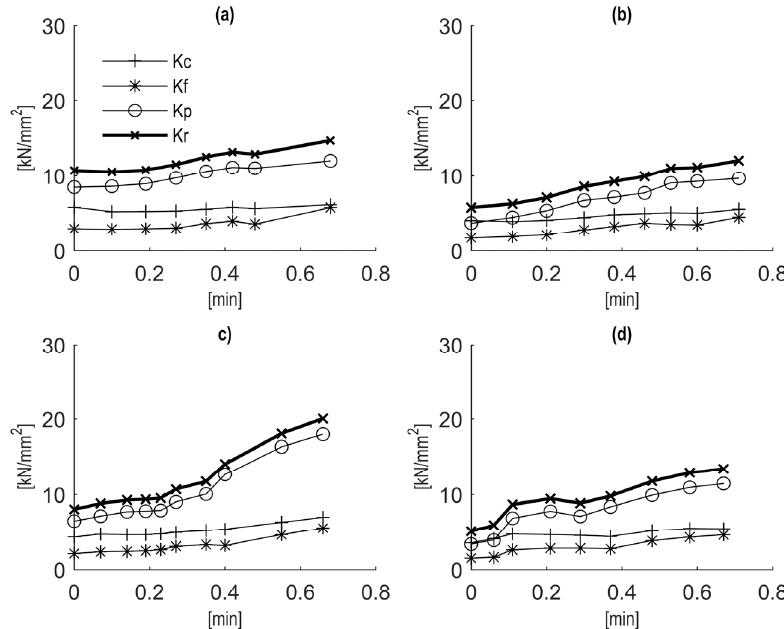
Figure 7. Specific force components vs machining time with the PCBN tool supplied by Seco for different cutting conditions. ( a ) V = 200 m/min; f = 0.15 mm/rev; d = 0.15 mm; ( b ) V = 200 m/min; f = 0.15 mm/rev; d = 0.25 mm; ( c ) V = 300 m/min; f = 0.15 mm/rev; d = 0.15 mm; ( d ) V = 300 m/min; f = 0.15 mm/rev; d = 0.25 mm.